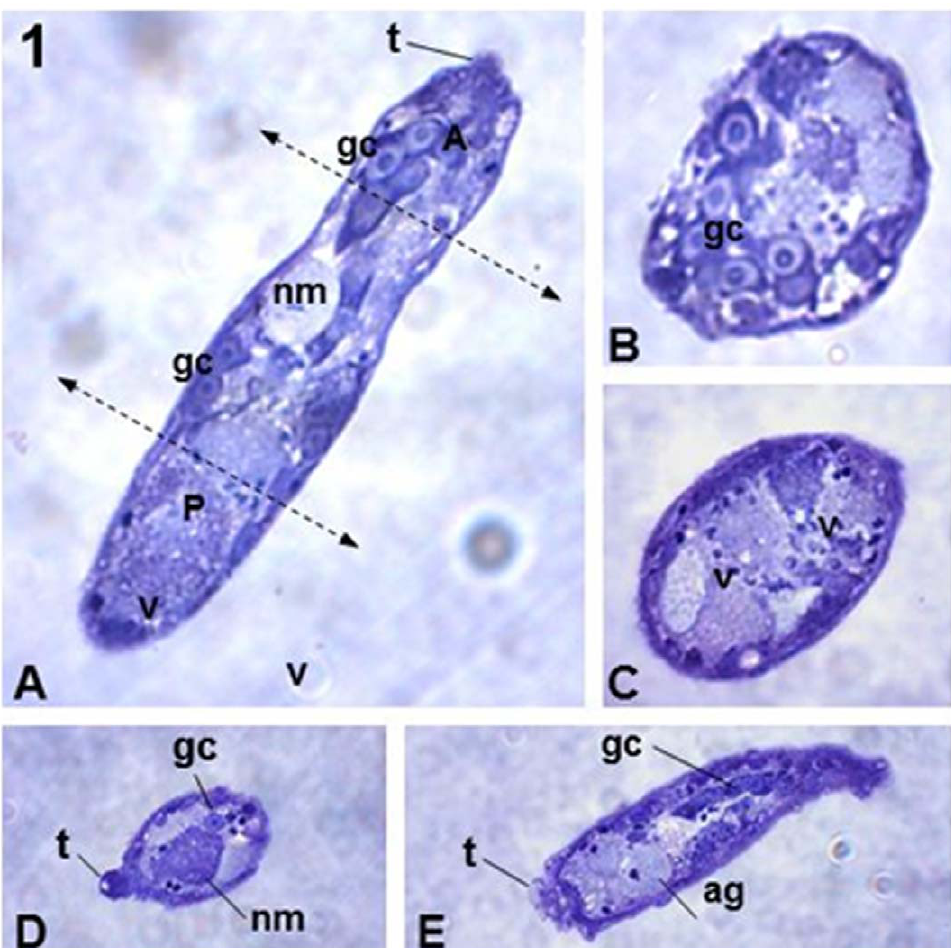
Figure 1. Histological sections showing distinct views of S.mansoni sporocysts. ( A ) Longitudinal section of the sporocyst medial plane showing the main internal organelles: germinal cells (gc), neural mass (nm), terebratorium (t) and several vesicles (v). The two dotted lines delimit the anterior (A) and posterior (P) regions of the parasite. ( B ) Transversal section of the anterior region of the parasite showing the gc. ( C ) Transversal section of the posterior region of the parasite, showing several types of v. ( D ) Oblique section of the anterior region of the parasite, showing the t, gc and nm. ( E ) Oblique sequential section of the anterior region of the parasite showing the large area of the t, as well as the apical glands (ag) and gc. Magnification